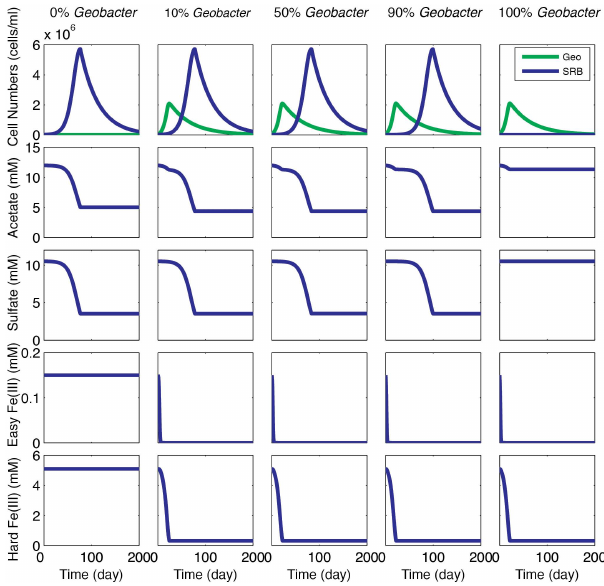
Fig. 3. Ideal batch reactor model simulations with varying initial ratio of Geobacter and SRB. In the cell number row, green line indicates Geobacter , blue line indicates